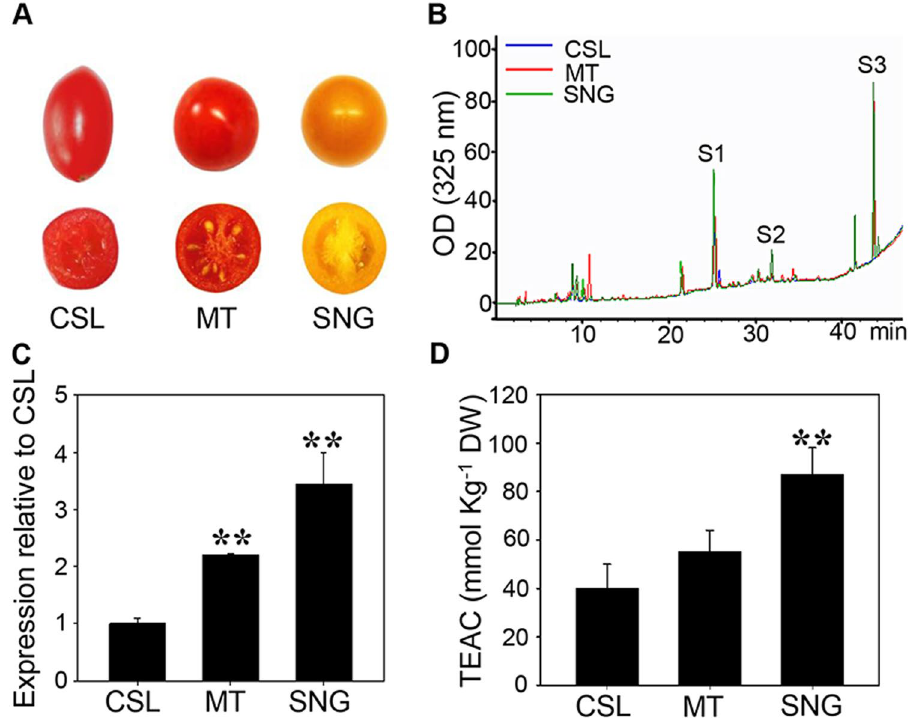
Figure 2. Phenotypes of three cherry tomato cultivars. ( A ) Phenotype of fruit in three cherry tomato cultivars. CSL, Csl09-03; MT, Micro-Tom; SNG, Sheng Nv-Guo. ( B ) HPLC analysis of extracts from three cherry tomato cultivars. S1, quercetin rutinoside (rutin); S2, kaempferol rutinoside; S3, naringenin chalcone. ( C ) Relative expression levels of SlMYB12 in three cherry tomato cultivars. Each value was normalized to ASR1 expression and is indicated as the mean ± standard deviation of three experimental replicates. ( D ) Total antioxidant capacity in three cherry tomato cultivars. Fresh and skin antioxidant activities in mature tomato fruits of each cultivar. Three different tomato fruits of each cultivar were pooled for detection. Each value represents repeated four times independent experiments, and the vertical bars expressed the arithmetic means ± standard deviations (SD). ** P <